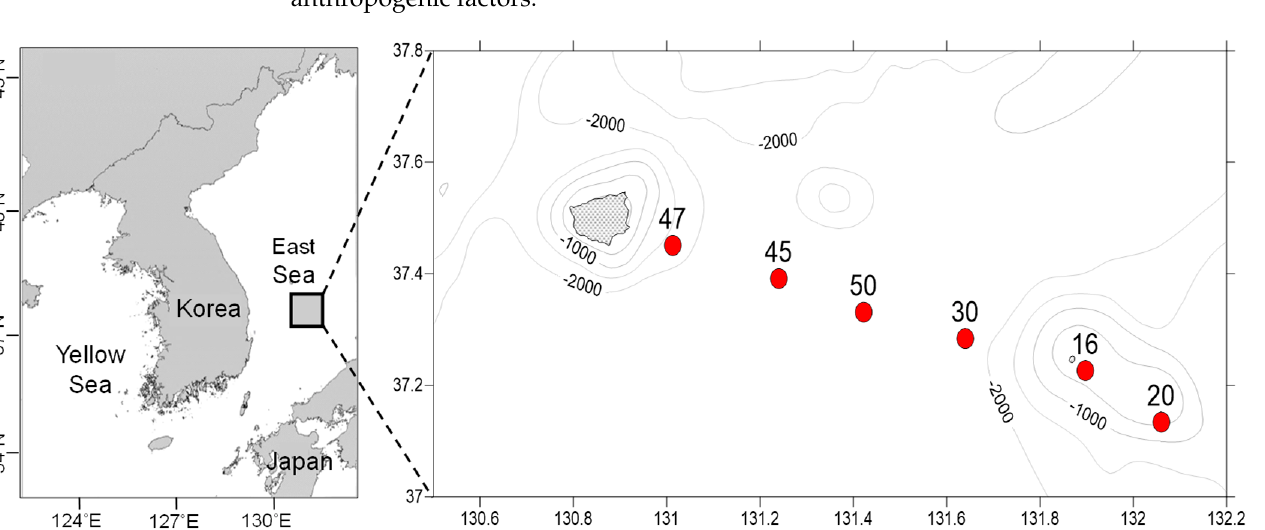
Table 1. Regional and seasonal environmental variables in the study area.